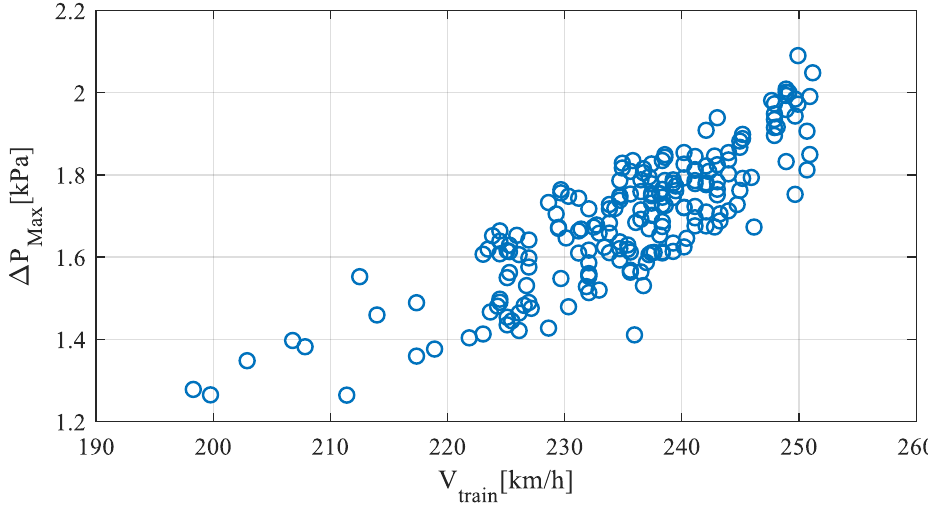
∆ P max of the 203 single train passages as a function of train speed. Appl. Sci. 2020 , 10 , x FOR PEER REVIEW